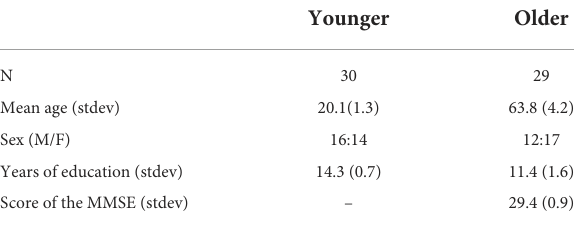
TABLE 1 Summary of participant